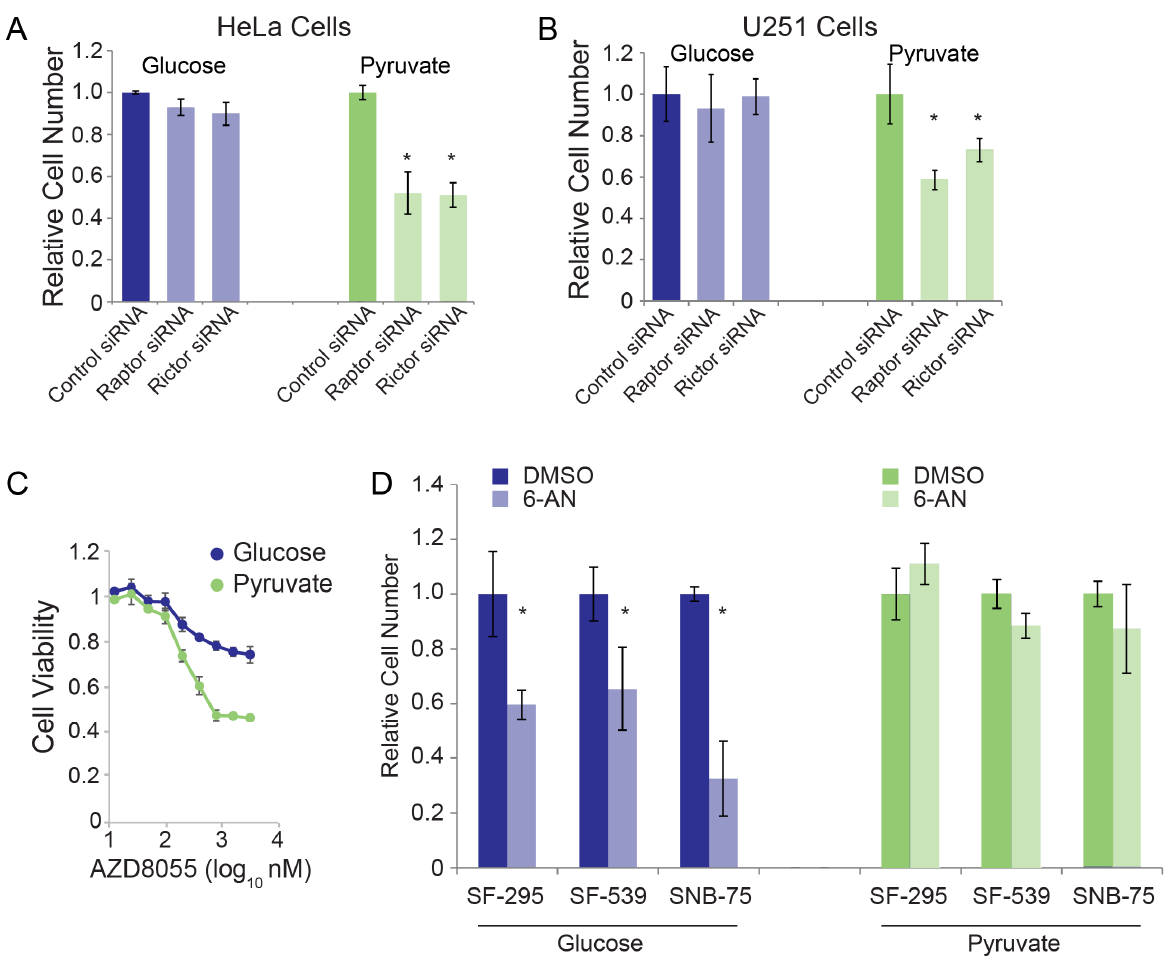
Figure 2. Sensitization of cells under restricted nutrient sources. ( A ) HeLa and ( B ) U251 cells were cultured in glucose or pyruvate-restricted medias and transfected with the indicated siRNAs. Seventy-two hours post transfection, cell numbers were assessed. ( C ) HeLa cells cultured in glucose or pyruvate-restricted media were treated with the indicated doses of mTOR inhibitor AZD8055. ( D ) Glioblastoma cell lines cultured in glucose or pyruvate-restricted medias were treated with the PPP inhibitor, 6-AN, followed by assessing cell numbers. Asterisks indicate p < 0.05 by Student’s t -test .